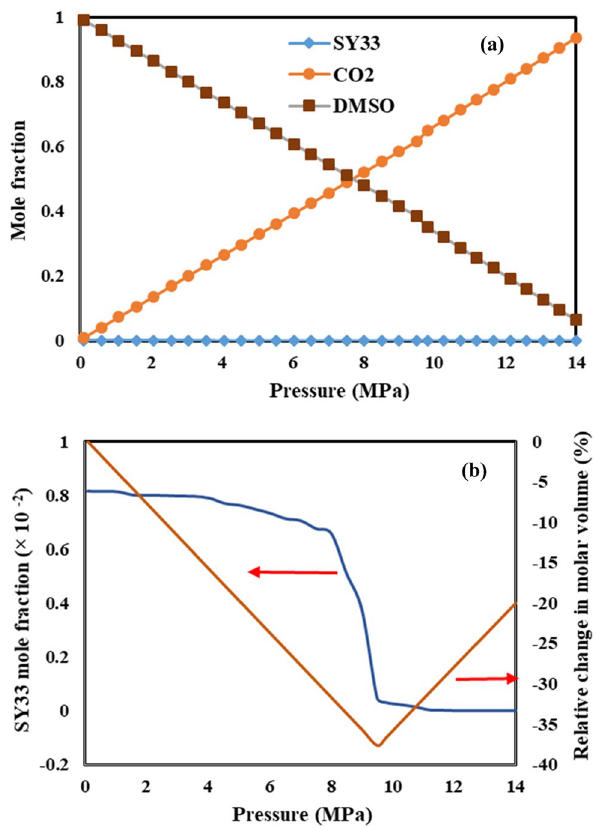
Figure 9. Mole fraction of components in the liquid phase of the ternary system of CO 2 –DMSO–SY33 at 328 K, calculated by the PR-EoS, and (b) Mole fraction of SY33 along with relative change in molar volume at 328